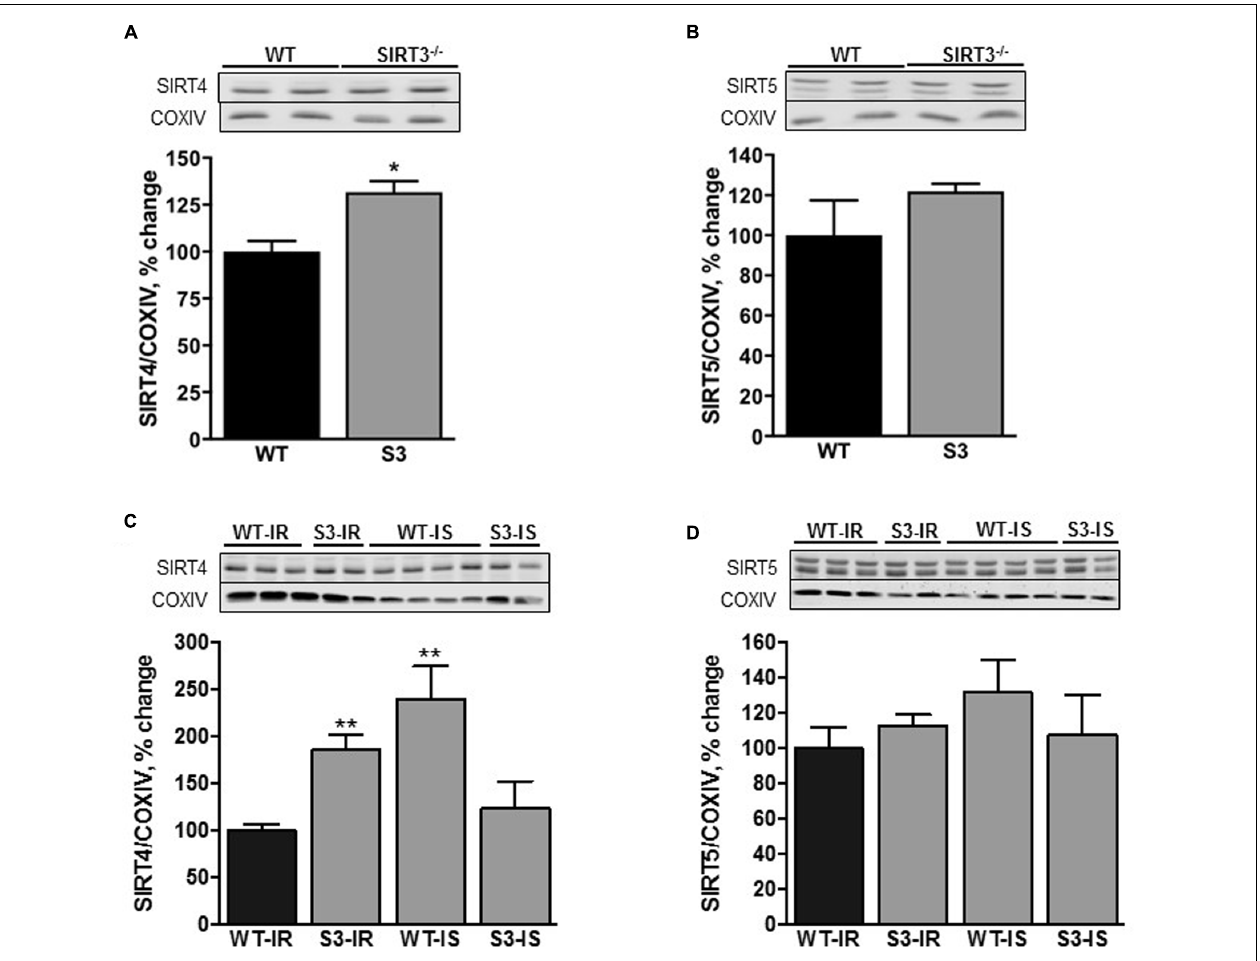
FIGURE 2 | SIRT4 (A,C) and SIRT5 (B,D) levels in cardiac mitochondria isolated from WT and SIRT3 − / − non-perfused (A,B) or perfused (C,D) mice. Representative immunoblots ( upper panels , A – D ) of the proteins were obtained by Western blot analysis. Proteins were normalized to cytochrome c oxidase (COXIV), a mitochondrial housekeeping protein, and expressed as percentage change relative to the WT group ( bottom panels, A–D ). Groups are the same shown in Figure 1 . ∗ P < 0.01, ∗∗ P < 0.001 vs. WT.